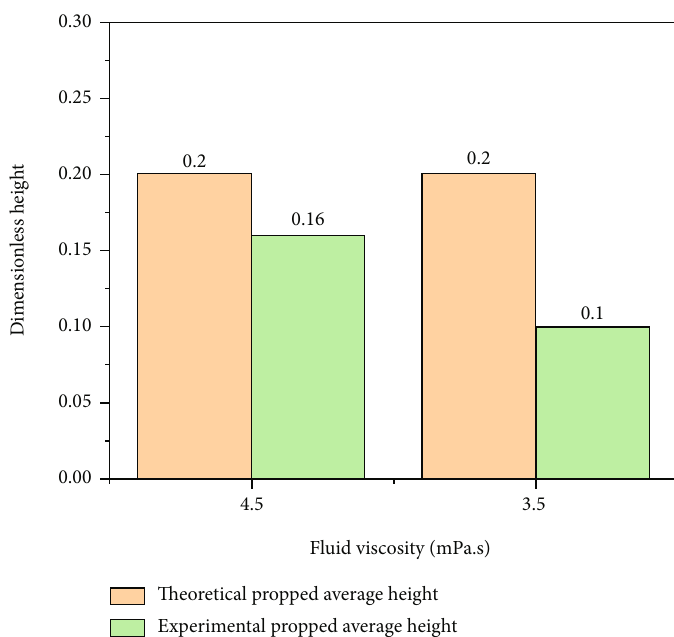
Figure 14: Comparison of placement results of ceramic proppant at di ff erent displacement rates.